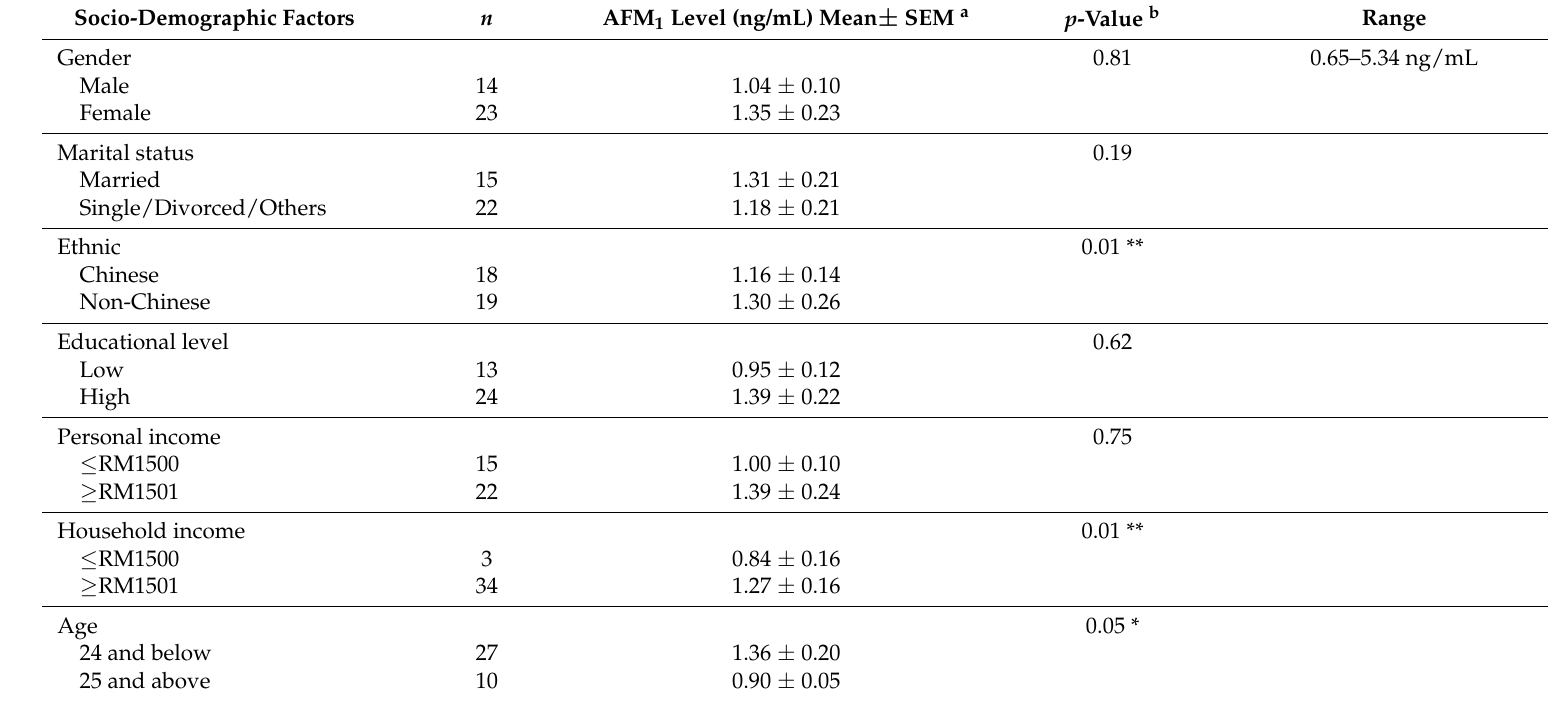
Table A2. AFM 1 level based on socio-demographic factors ( n =